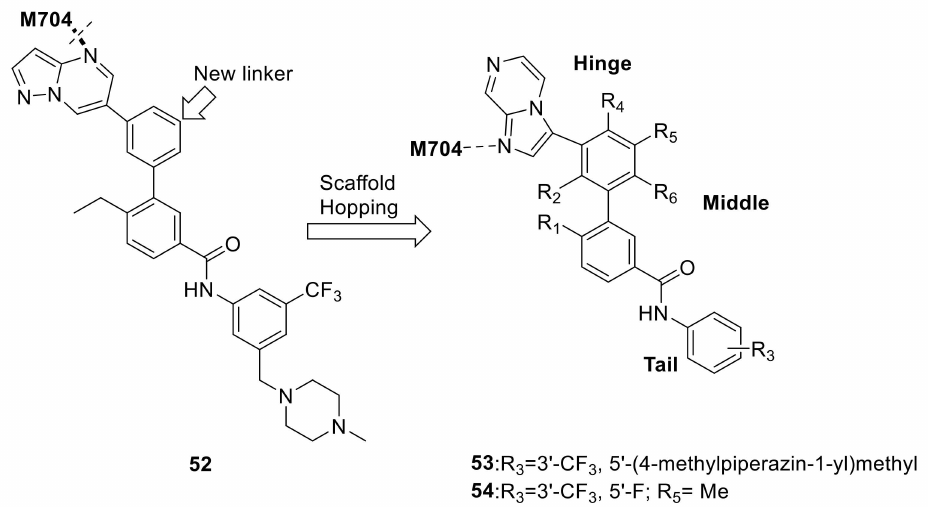
Figure 22. Structural-based design of compound 52 – 54 . Reprinted with permission from Ref. [155]. During the research for development of c-Jun N-terminal kinase 3 (JNK3) new in- hibitors, Dou et al., discovered that a potent JNK3 inhibitor ( 55 , Figure 23) possessing a 3,4-dihydroquinoxalin-2(1 H )-one core structure displayed an interesting DDR1 inhibition activity (IC 50 = 0.16 µ M) [156]. The modeling study of compound 55 into the active site of DDR1 indicated that the oxygen atom in the quinoxaline core and hydrogen atom of NH formed two hydrogen bonds to the NH and backbone carbonyl of Met704. Thus, further optimization of compound 55 may lead to the development of more potent and selective quinoxaline-based DDR1 inhibitors.